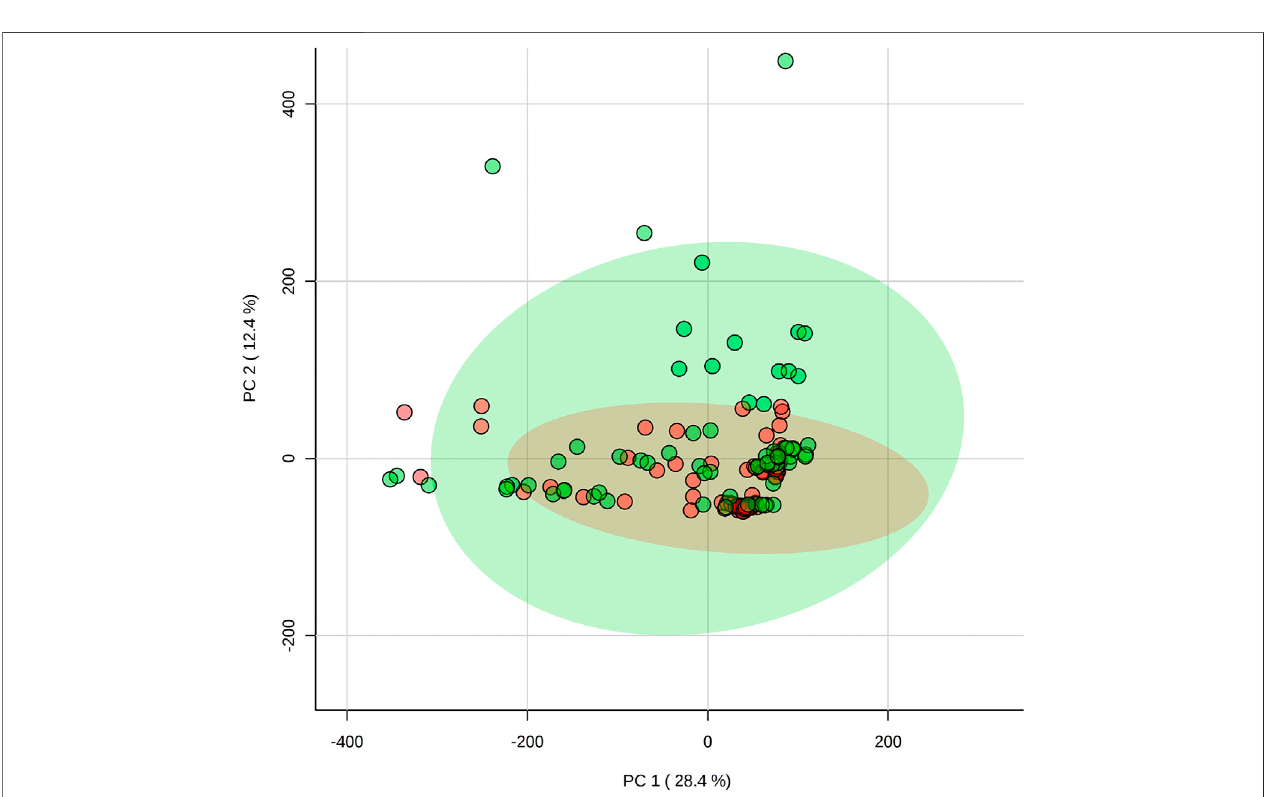
FIGURE1| Comparisonofpre-gamemetabolomes(metabolicpro fi le)betweenbackcourtandfrontcourtplayersduringelitemalebasketballgamesusingprincipal component analysis. Red: backcourt, green: frontcourt.